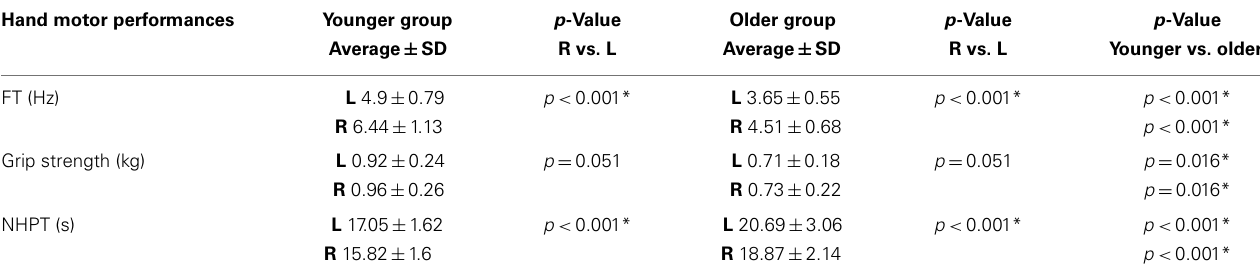
Table 4 | Hand motor performances are shown in both groups of participants (younger and older) . Hand motor